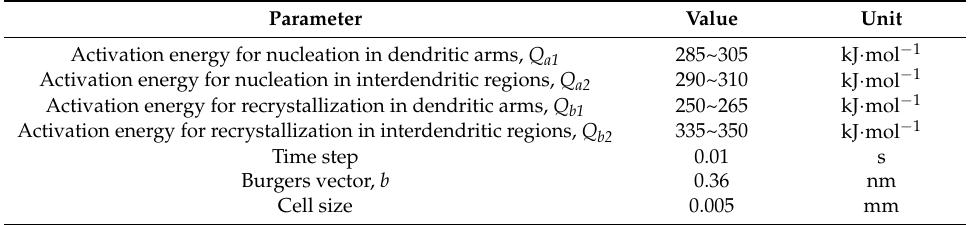
Table 3. Key parameters used in cellular automaton (CA) simulation.